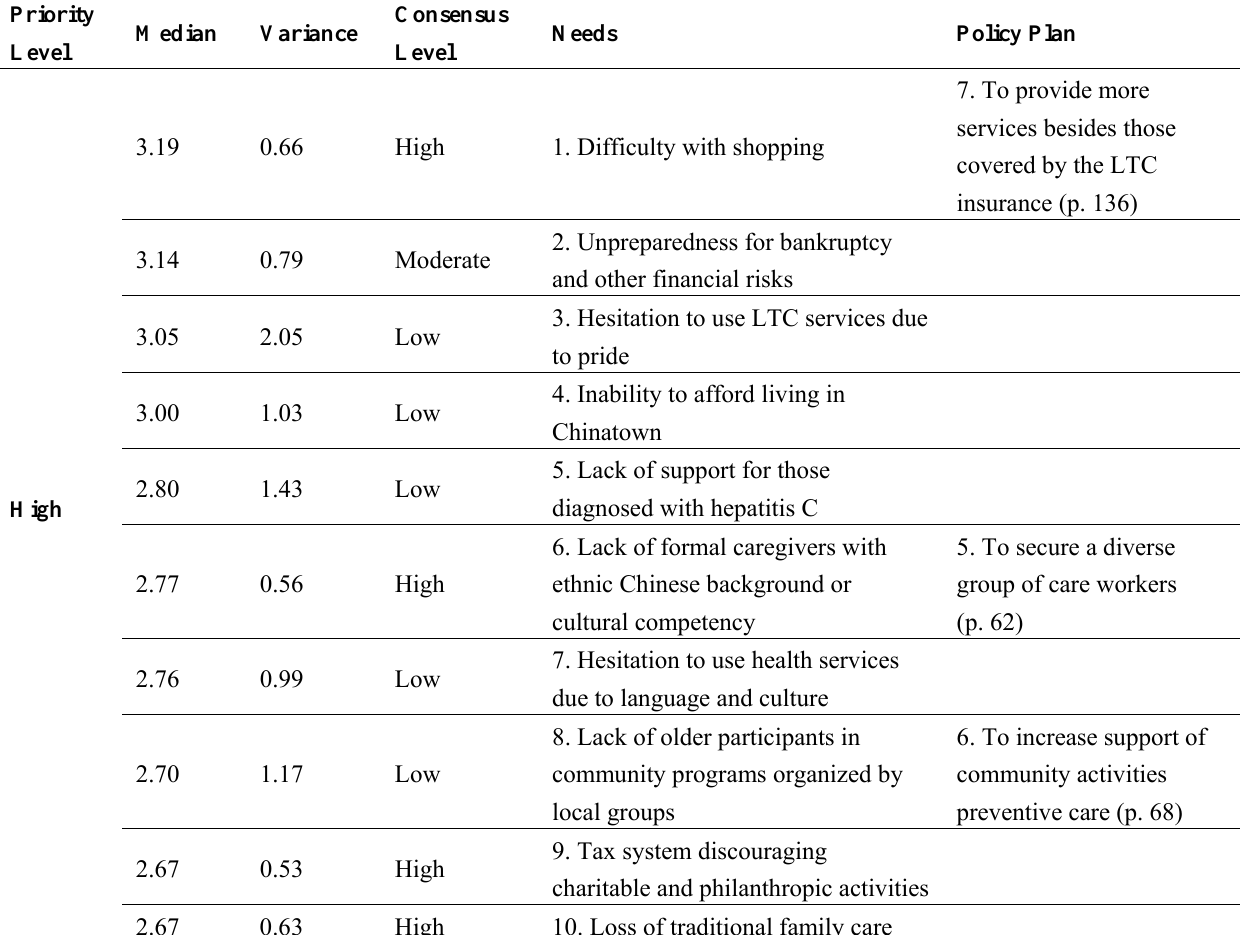
Table 2. High priorities, levels of consensus, and corresponding city’s policy plan for 30 needs identified from focus group interviews with the ethnic Chinese